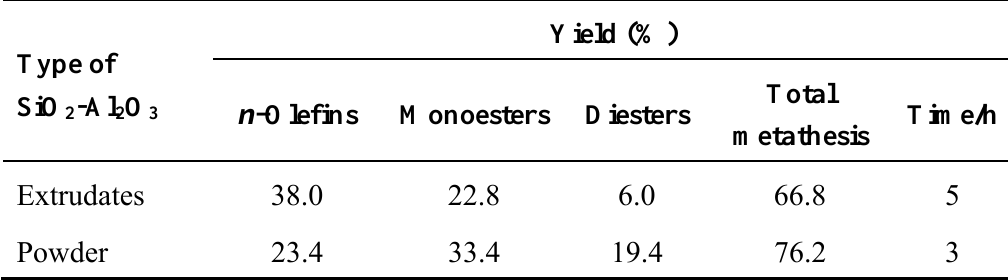
Table 2. Yield (in mol%) of products resulting from cross-metathesis of methyl oleate (MO) with methyl linoleate (ML) using a 3 wt% Re